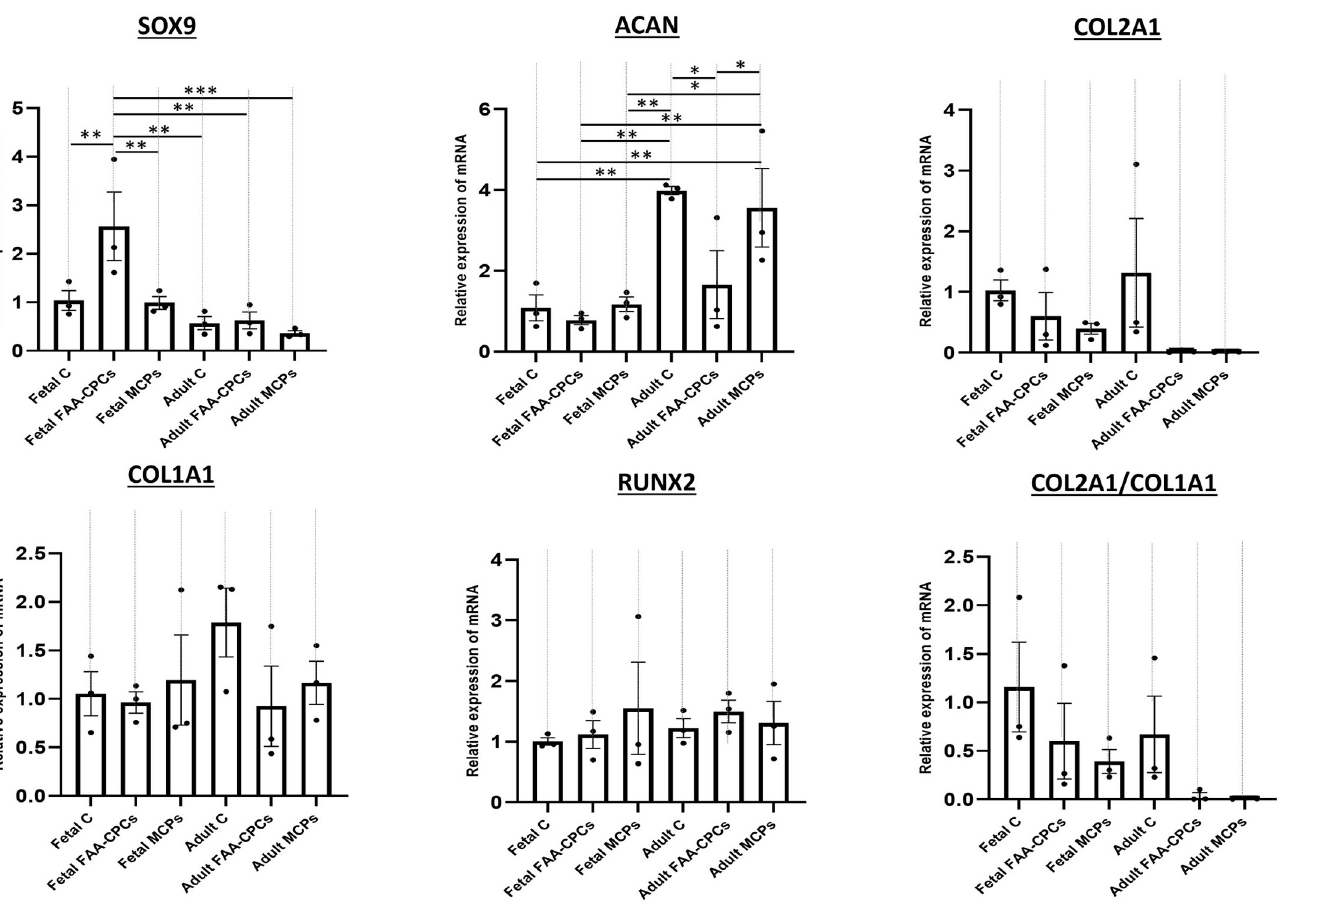
Fig 5. Relative mRNA expression encoding chondrogenic markers (SOX-9, ACAN, COL2A1), fibrocartilage marker (COL1A1), and hypertrophic markers (RUNX2) were determined by qRT-PCR. All results were normalized to the housekeeping gene, GAPDH( Δ Ct), and ΔΔ Ct was obtained in comparison to the Fetal Chondrocyte group. 2^- ΔΔ Ct values are expressed as mean ± standard error mean ( * P < 0.05, ** P < 0.01, *** P < 0.001). All experiments were run with three biological samples (n = 3) in two technical replicates. Overall, the Fetal FAA-CPCs displayed higher levels of SOX-9 when compared to the other groups. All groups displayed constitutive expression of ACAN with the adult chondrocytes and MCPs expressed significantly higher levels. s groups.